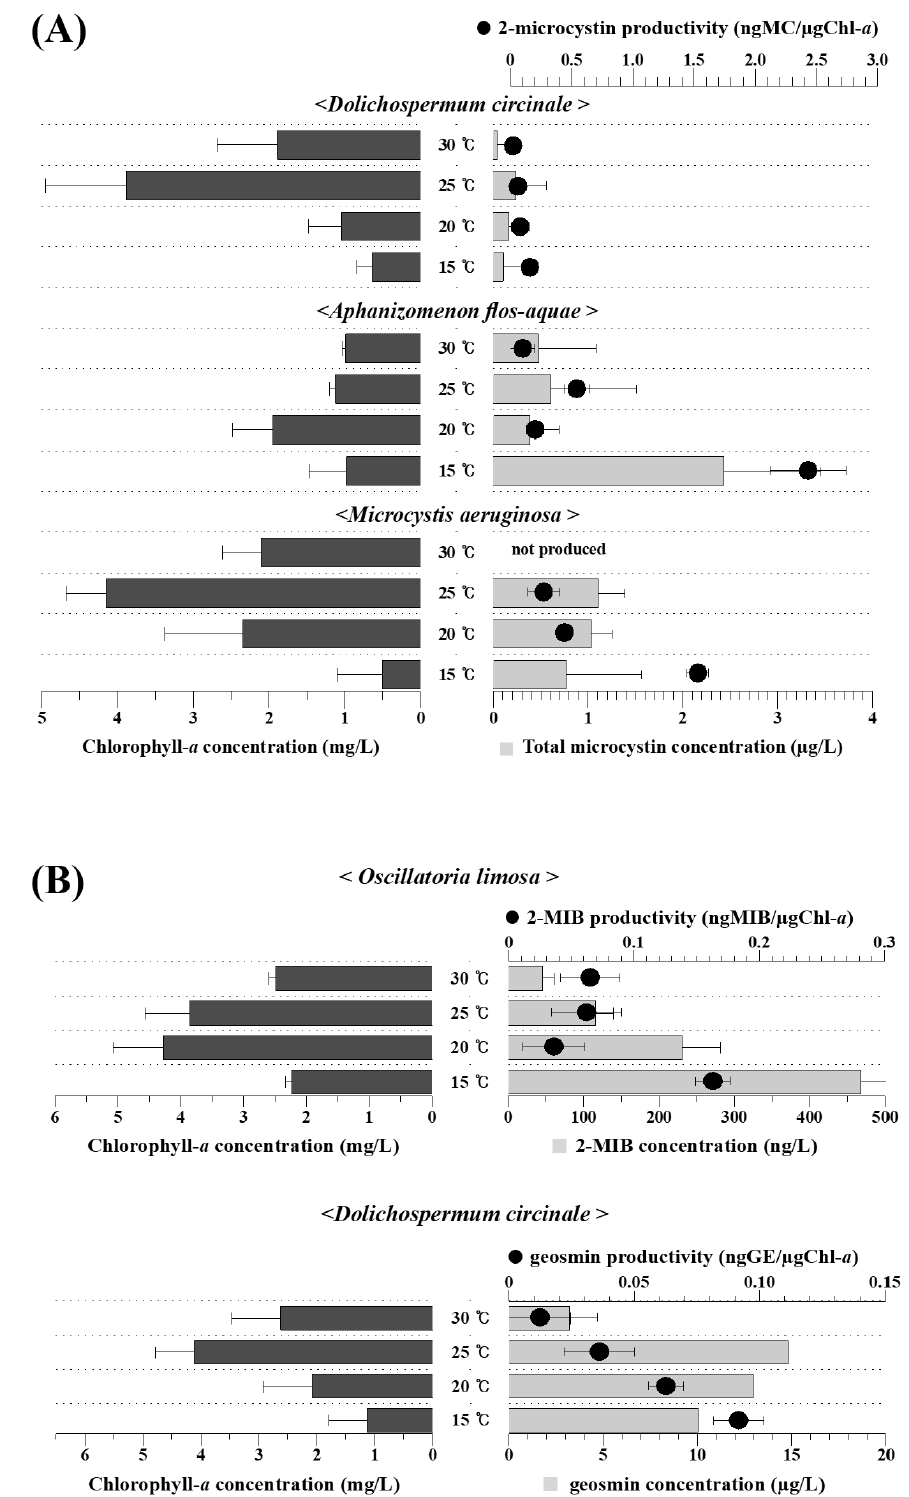
Figure 4. Concentration of chlorophyll- a (black bars) and the harmful materials (gray bars) microcystin ( A ) and geosminand 2-MIB ( B ) produced by various cyanobacteria at different temperatures. Black circles indicate productivity (the ratio of harmful material concentration to chlorophyll- a concentration) of harmful material produced by cyanobacteria.